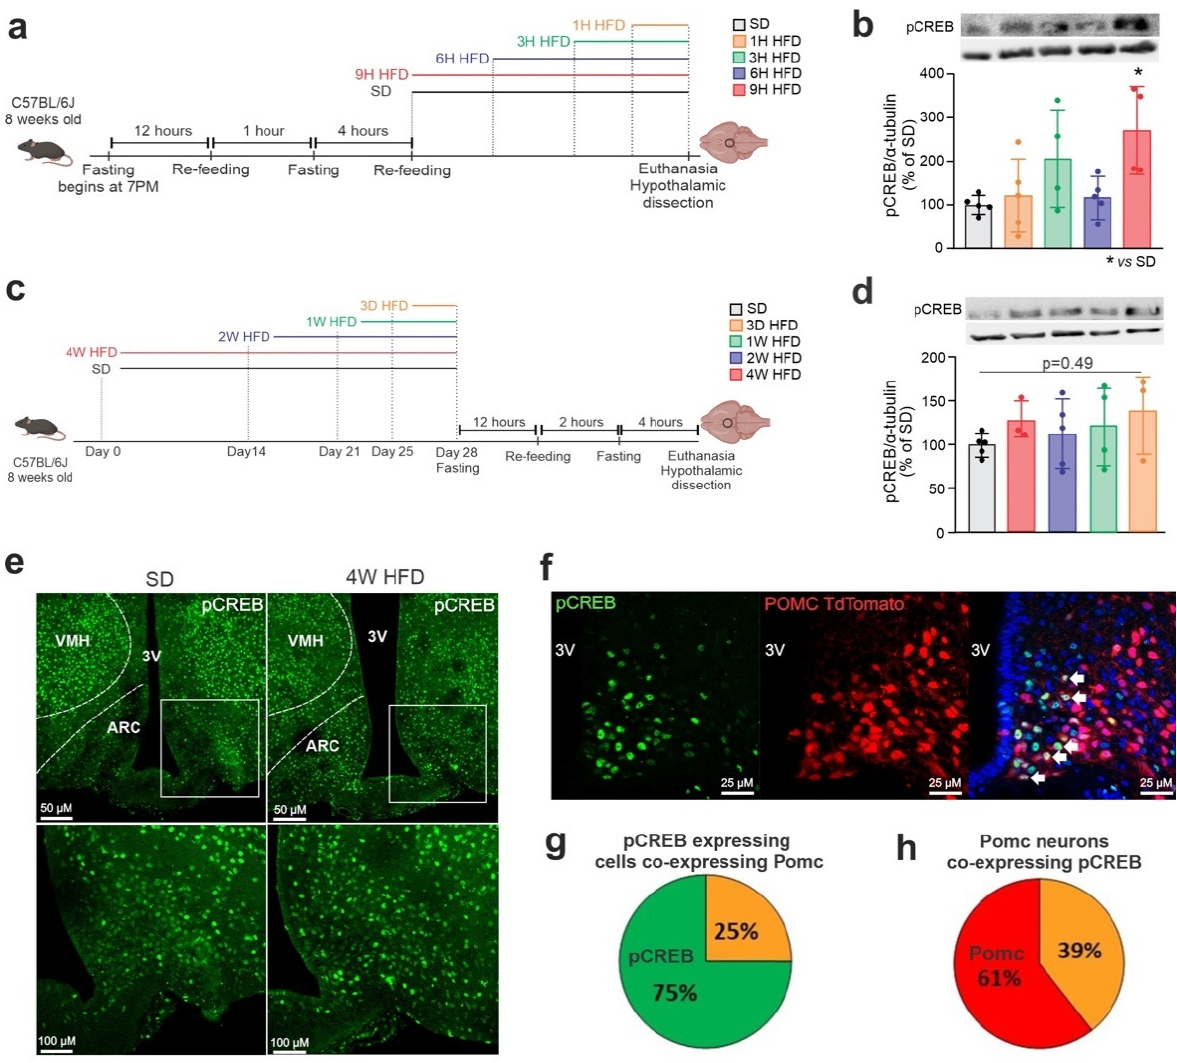
Figure 3. HFD modulates pCREB expression and distribution in the hypothalamus. Adult male C57BL/6J mice were fed on an HFD for chronic and acute periods. ( a ) Schematic representation of the experimental protocol of HFD-acute feeding; ( b ) Western blotting of the hypothalamus after an acute period of HFD. ( c ) Schematic representation of the experimental protocol of HFD-chronic period; ( d ) Western blotting of the hypothalamus after a chronic period of HFD; ( e ) coronal brain sections of mediobasal hypothalamus of mice fed an SD and 4 weeks of HFD were immunostained for pCREB; the anatomical boundaries are depicted. 3V, third ventricle; ARC, arcuate nucleus; VMH, ventromedial hypothalamus; ( f ) coronal brain sections of Pomc tdTomato were immunostained for pCREB. Quantification of double-labeled cells; ( g ) number of pCREB-expressing cells co-expressing Pomc; and ( h ) number of Pomc neurons co-expressing pCREB. In ( g , h ), orange represents colocalization. Data are presented as means ± SD. n = 4–5 per group. One-way ANOVA followed by Tukey’s post hoc test used for statistical analyses. * p ≤ 0.05 in comparison with the SD group.